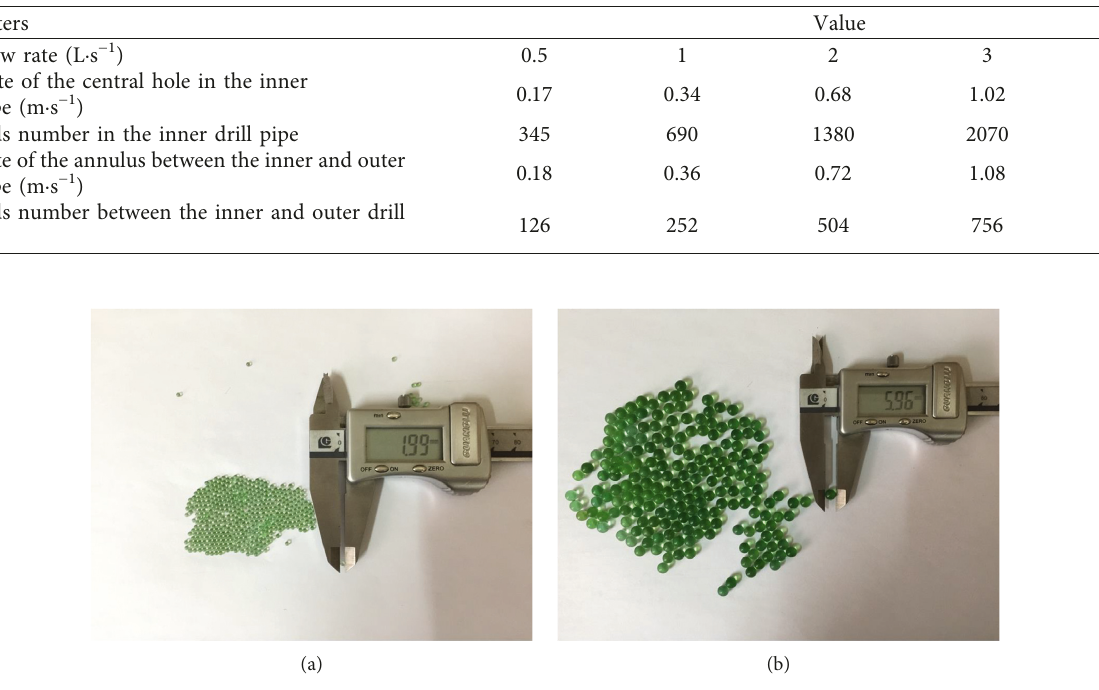
Table 4: Flow parameters of the flushing fluid during the experiment.